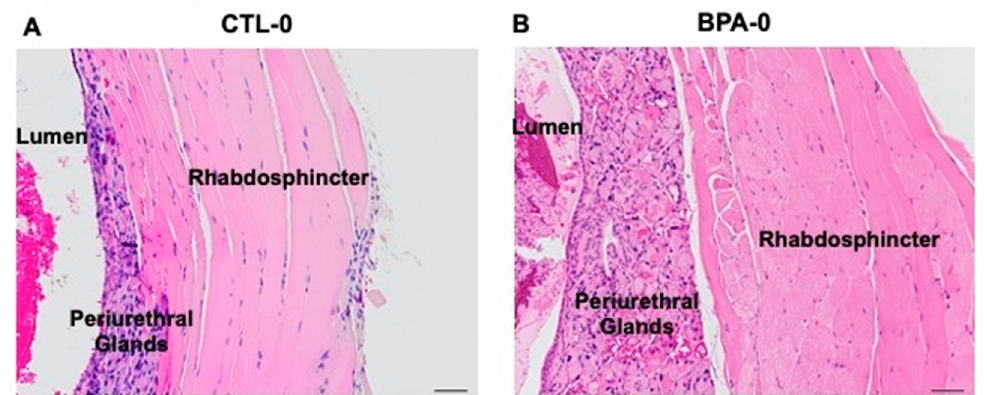
Figure 2. Post-prostatic urethra between the prostatic and penile urethra. Hematoxylin and eosin stained sections of the urethra wall from adult male mice. ( A ) CTL-0 male, showing normal lumen and urethra wall: periurethral mucus glands, rhabdosphincter muscle. ( B ) BPA-0 male showing thickened urethra wall due to glandular hyperplasia and an increase in thickness of the rhabdosphincter (20× magnification).